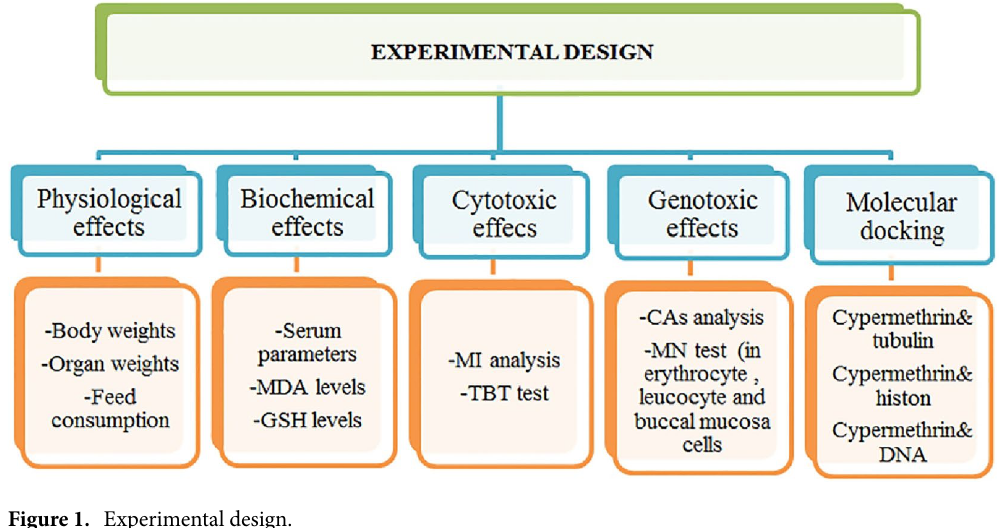
Figure 1. Experimental